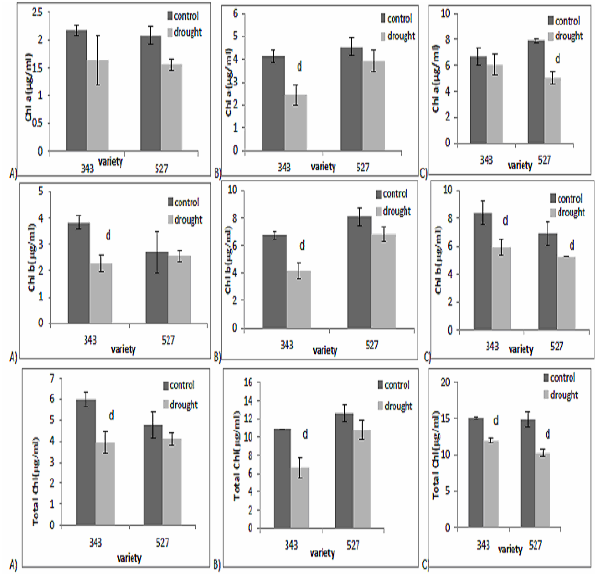
Fig. 1. Chlorophyll a (Chl a),Chlorophyll b (Chl b) and total chlorophyll content in shoots of drought tolerant (‘PBW 527 ’ ) and drought sensitive (‘PBW 343 ’ ) cultivars of Triticum aestivum harvested at three different stages: 30 DPS (A), 57 DPS(B) and 90 DPS(C) under control and drought conditions. DPS: Days Post Sowing. Data shown are Mean ±SD of three replicates; d indicates significant difference